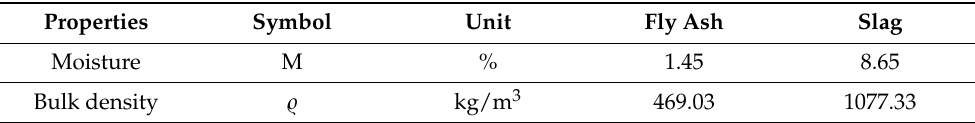
Table 1. Basic technical properties of fly ash and slag.